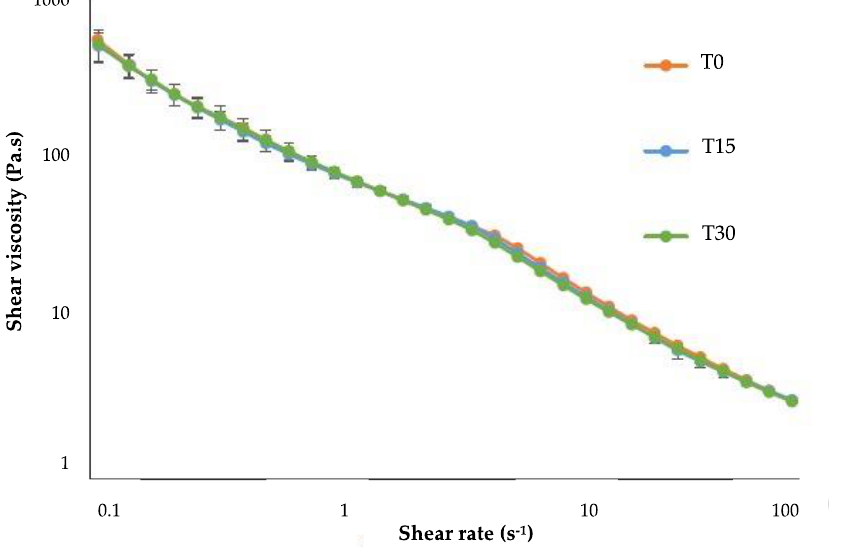
Figure 3. Graphic that represents the variation of shear viscosity (Pa.s) with shear rate (s − 1 ) for O/W formulation containing C. sativa shells extract at different storage times (T0, T15, and T30) (mean ± standard deviation, n = 3).